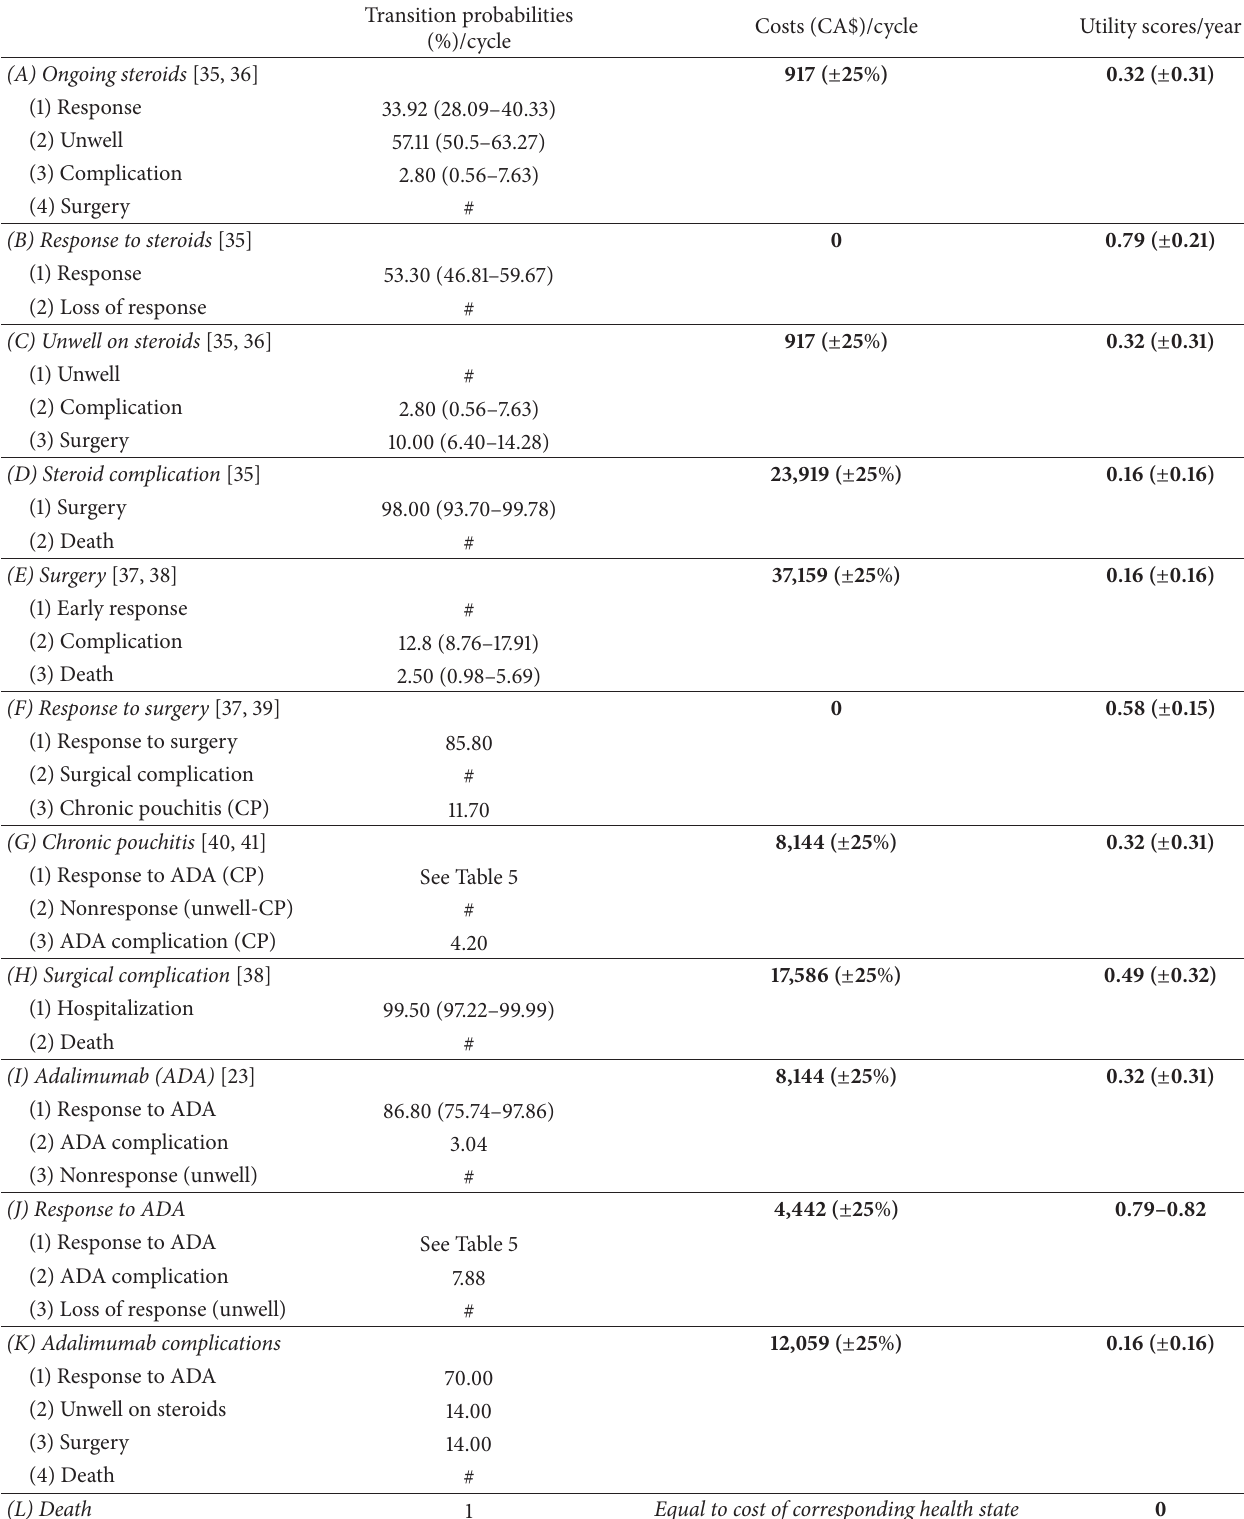
Table 3: Markov model input parameters for chronic ulcerative